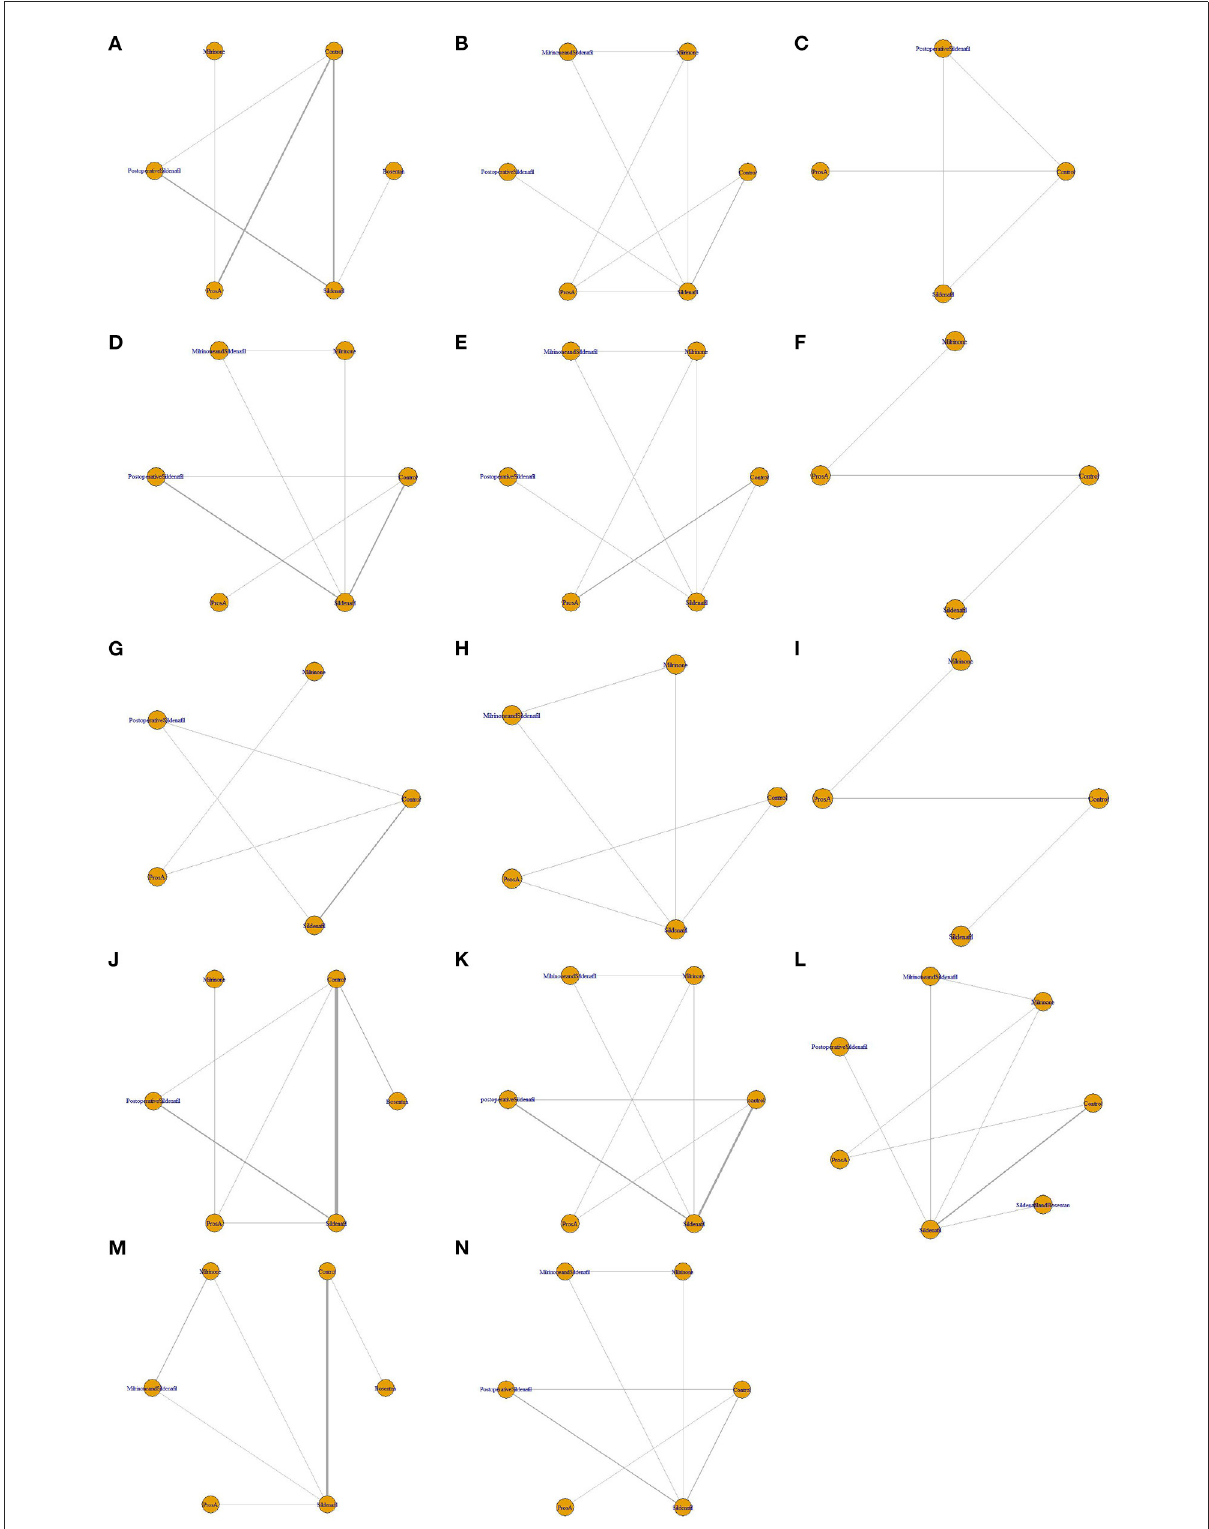
FIGURE3 Network diagrams of fourteen outcomes of different interventions. (A) Mean pulmonary artery pressure (mPAP) change; (B) pulmonary artery systolic pressure (PASP) change; (C) pulmonary vascular resistance (PVR) change; (D) pulmonary arterial/aortic pressure (PA/AO) change; (E) systolic blood pressure (SBP) change; (F) heart rate (HR) change; (G) blood oxygen saturation (SpO 2 ) change; (H) oxygenation index (OI) change; (I) partial pressure of arterial oxygen (PaO 2 ) change; (J) mechanical ventilation duration; (K) intensive care unit stay (ICU) duration; (L) Hospital stay duration; (M) mortality; (N) pulmonary hypertension (PH) crisis. The network plots show how a comparison of different intervetions. Each vertex represents a kind of intervention. The thickness of the straight line represents the number of trials